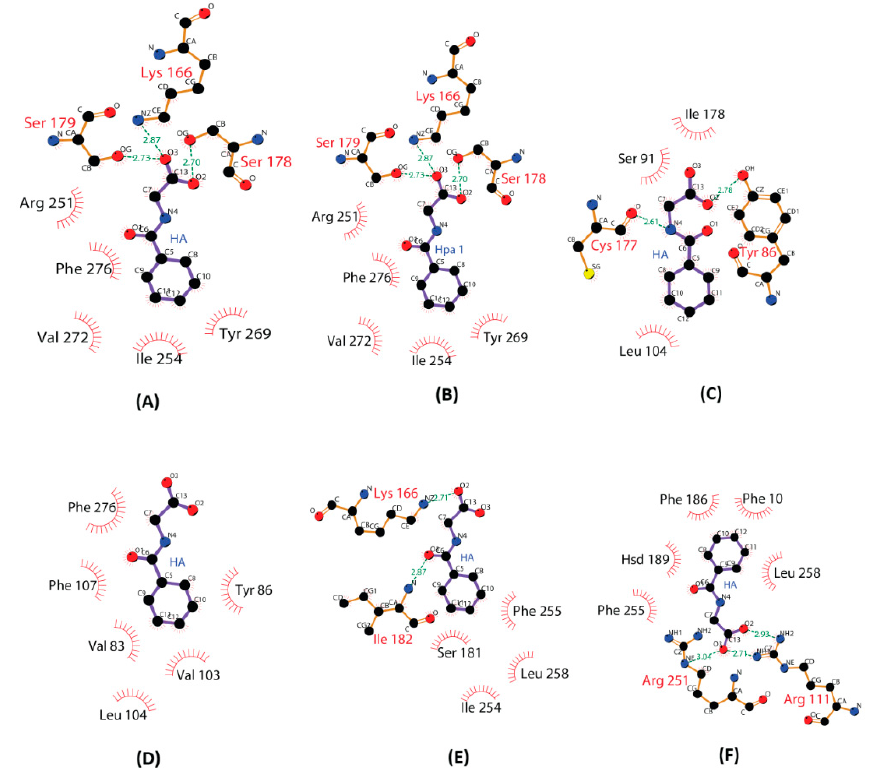
Figure 3. LigPlot representation of GPR109A/B residues interacting with Hippuric Acid (HA) in representative structure from most dominant cluster. All distances are in Å. ( A ) GPR109A-HA, pose-A0 ( B ) GPR109A-HA, pose-A1 ( C ) GPR109B-HA, pose-B0 ( D ) GPR109B-HA, pose-B1 ( E ) Chimera 3A4B-HA ( F ) Chimera 3B4A-HA.